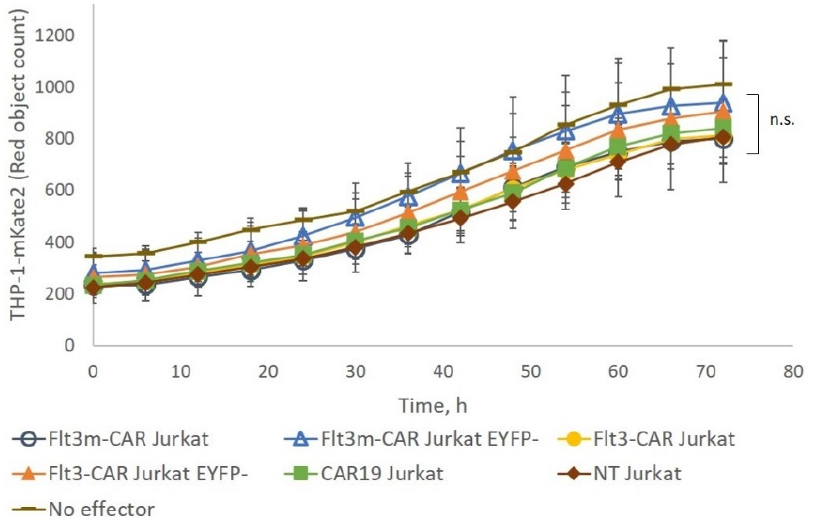
Figure 5. Flt3m-CAR Jurkat cells showed no cytotoxicity towards THP-1-mKate2 cells. Flt3m-CAR Jurkat cells, Flt3m-CAR EYFP − Jurkat cells, Flt3-CAR Jurkat cells, Flt3-CAR EYFP − Jurkat cells, CAR19 Jurkat cells, and non-transduced (NT) Jurkat cells were co-incubated with THP-1-mKate2 cells at an E:T ratio of 1:1. Empty dark blue circles refer to Flt3m-CAR T-cells, empty blue triangles to Flt3m- CAR EYFP − T-cells, yellow circles to Flt3-CAR T-cells, orange triangles to Flt3-CAR EYFP − T-cells, green squares to CAR19 T-cells, brown diamonds to NT T-cells, and dashes to wells with THP-1-mKate2 cells without any effector cells. Red object counts are shown in the figure, indicating the number of alive THP-1-mKate2 cells. Data are represented as mean ± SD. A Kruskal-Wallis test was performed to identify significant differences. n.s., not